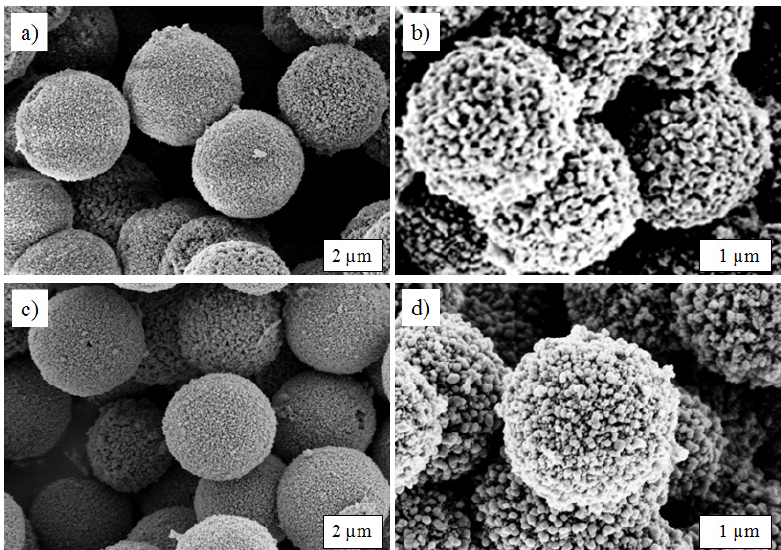
Figure 1. SEM images of LiFePO /C spheres before ( a and b ) and after ( c and d ) 4 calcination. ( a ) LFP180-2; ( b ) LFP250-1; ( c ) LFP 180-2-700; and ( d ) LFP250-1-700.